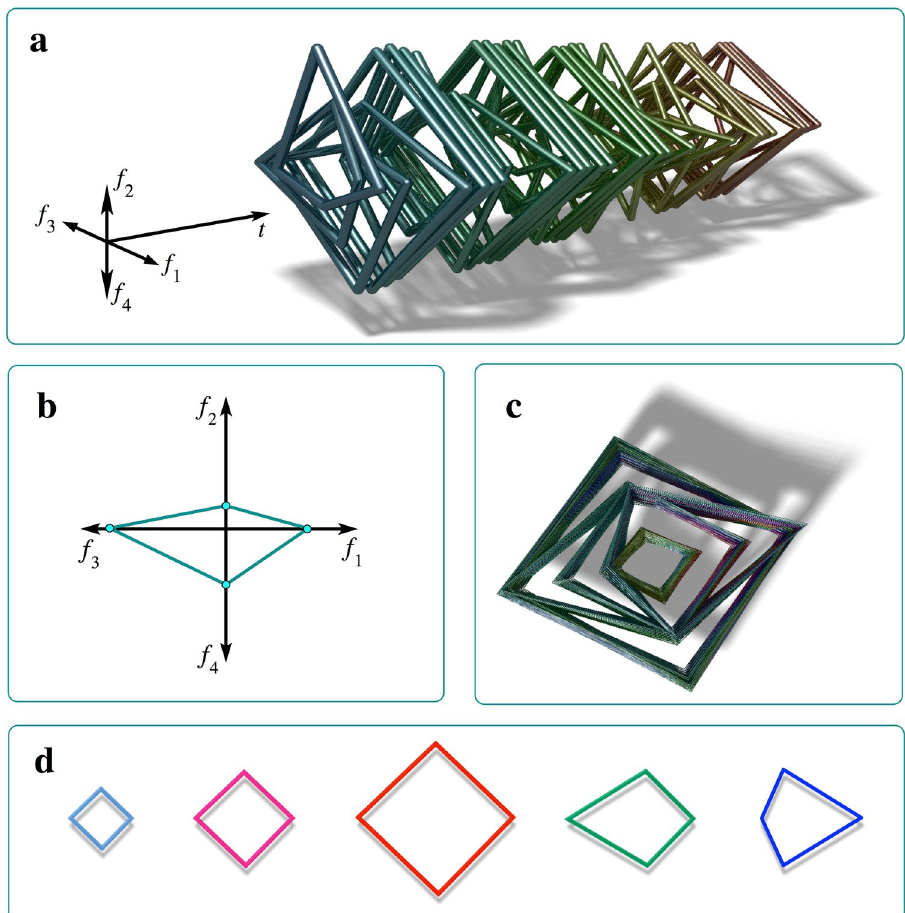
Figure 5. Automatic discovery and memorization of musical phrases. ( a ) The sight of music: a sequence of melody pieces represented as polygons, whose formation is illustrated in ( b ). The shade is only used to enhance visualization and carries no additional information. ( b ) Representing a four-note phrase with a polygon. ( c ) The resultant snapshot of the four-dimensional landscape V ( x , t ). The function V is shown with the smallest values on the top for visualization purposes. The sharp edges on the top represent the most typical musical patterns. ( d ) The most typical musical phrases automatically detected by the system (9),